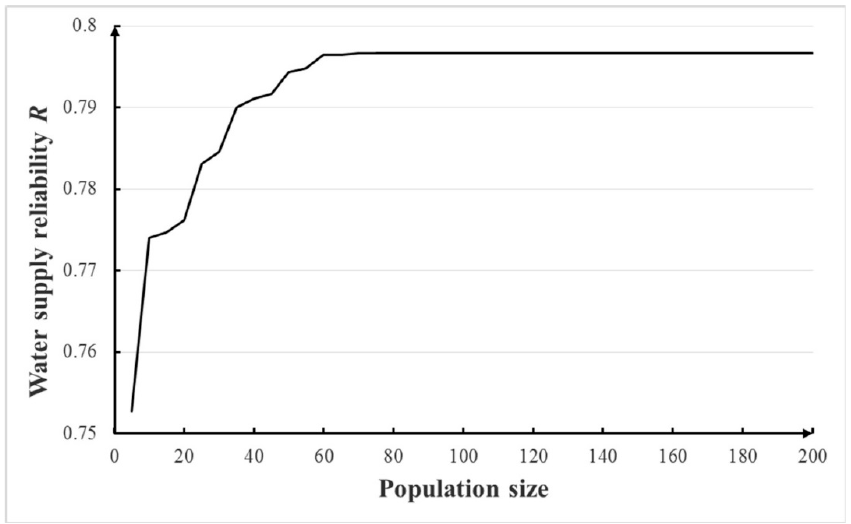
Figure 5. Sensitivity of population size in Monte Carlo GA.